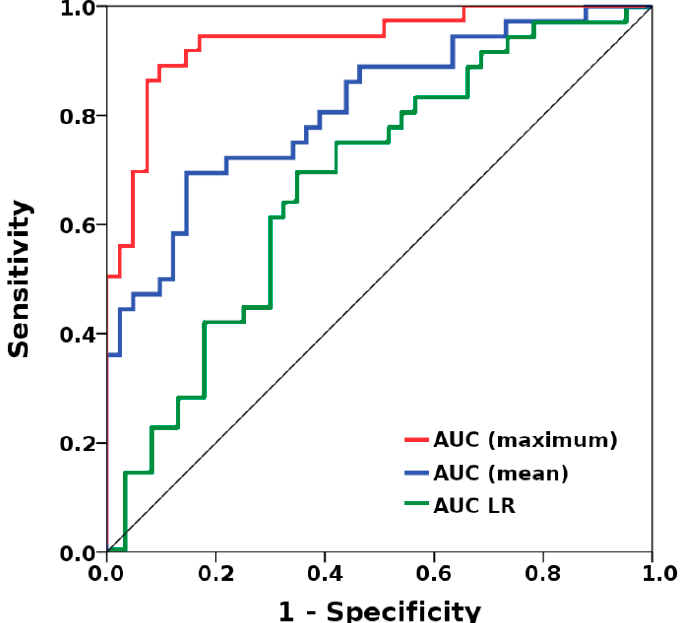
Figure 1. Multilayer perceptron neural network (MLP-NN)-based separation of metastatic and non-metastatic breast cancers yielded a maximum area under the receiver operating characteristic (ROC) curve (AUC) of 0.94, and a mean AUC of 0.82, while logistic regression (LR)-based separation yielded an AUC of 0.69.